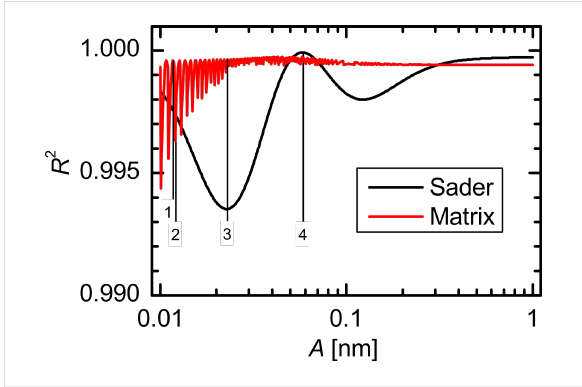
is shifted to smaller amplitudes compared to the Morse force law in Figure 2. The Sader–Jarvis method exhibits minima at amplitudes of 23 pm and 122 pm and a maximum at 58 pm. The matrix method shows again the periodic spikelike features. Additionally, for larger amplitudes the CoD R 2 does not converge to 1. The deconvolution quality expressed by the CoD R 2 ≥ 0.993 is also very high for the Lennard-Jones force law.